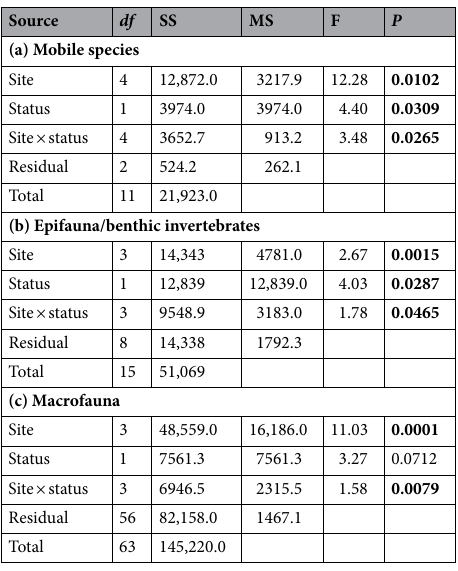
Table 2. Permutational multivariate analysis of variance results based on the Bray–Curtis similarity measure for square-root abundance data of: (a) mobile species; (b) epifauna and benthic invertebrates; and (c) macrofaunal species. Statistically significant p values (α = 0.05) are bold. Tests conducted using 9999 permutations under a reduced model. MR Motuora, NLB New Lagoon Bay, LB Lagoon Bay, PP